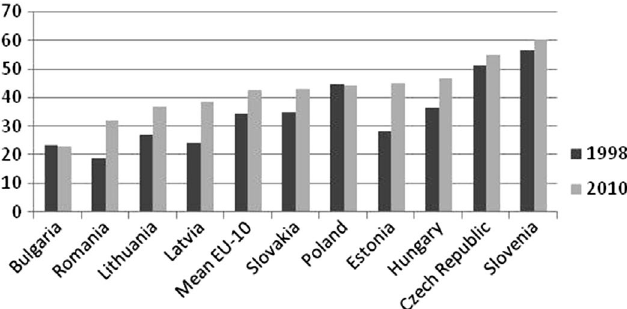
Fig. 2. Net earnings ratio expressed in purchasing power parity, in the EU-8+2 according to the average net earnings in the EU-15,